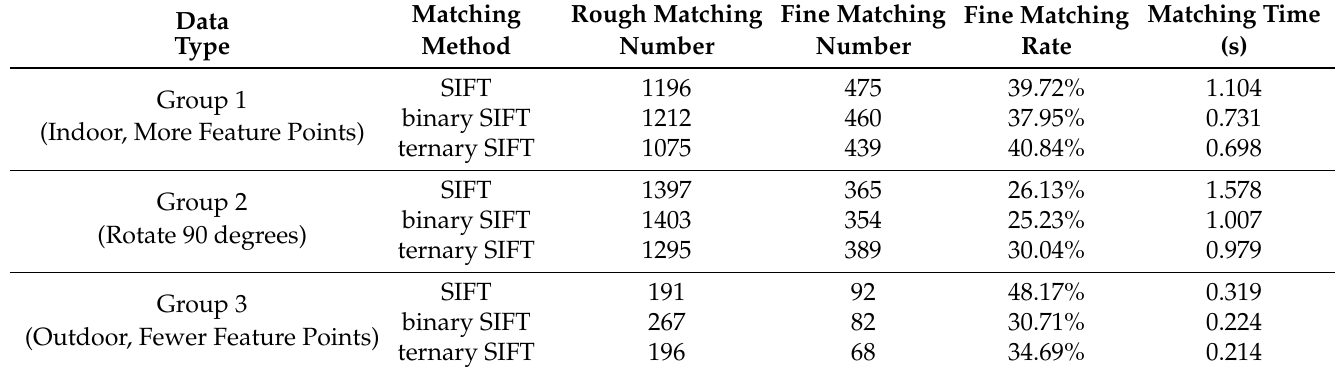
Table 1. Evaluation of matching results for different kinds of